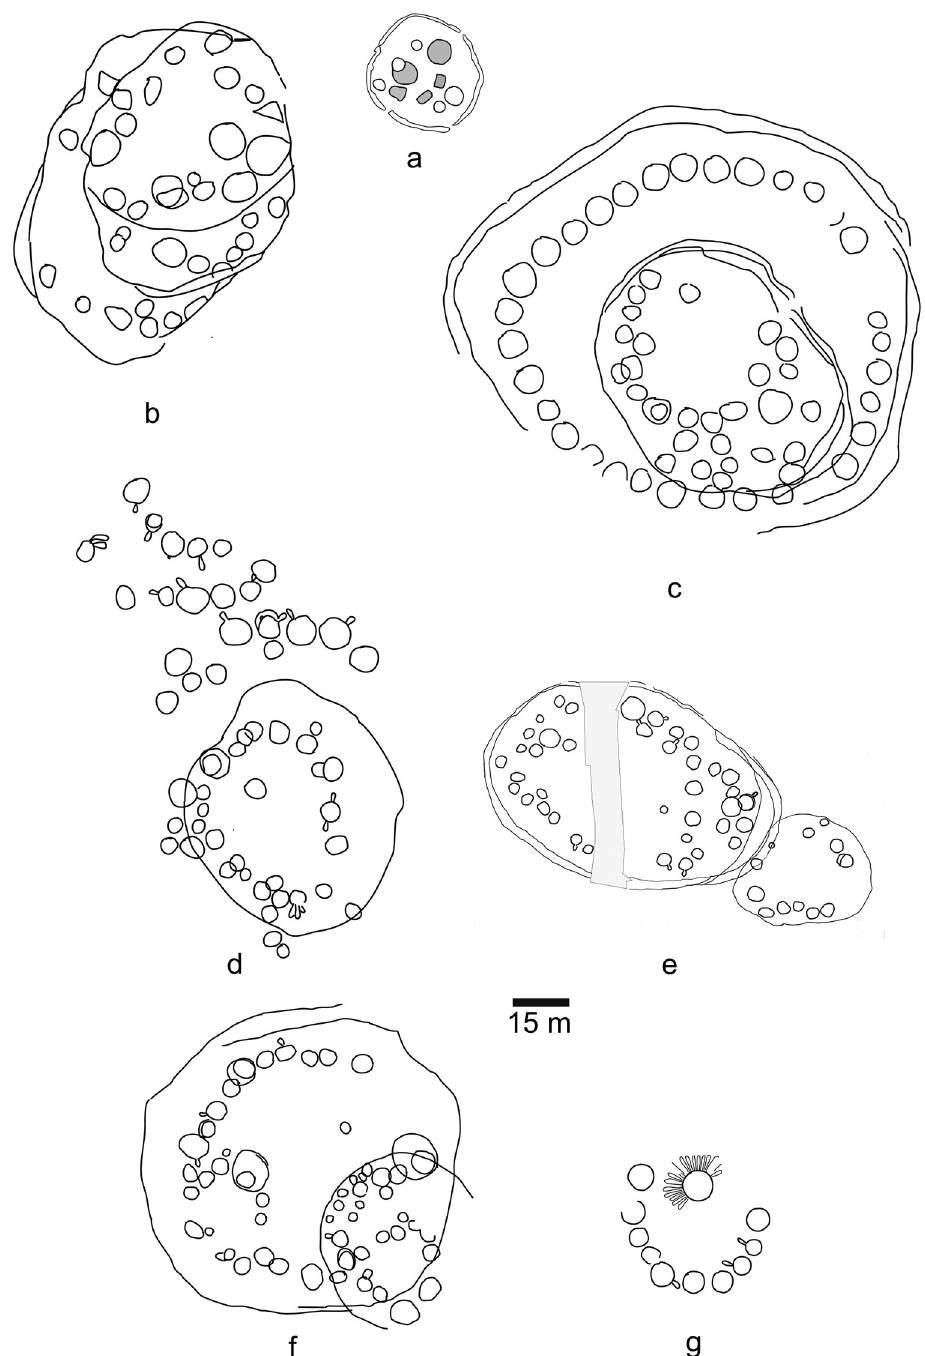
Fig 4. Site plans showing house and palisade outlines as inferred from postmold patterns for village sites discussed in the text: (a) Gnagey No. 3 (shaded structures represent the original site plan), (b) Fort Hill, (c) Peck No. 1, (e) Reckner, (f) Consol (shading represents roadway), (g) Peck No. 2, (f) Throckmorton. Overlapping house patterns represent rebuilding episodes rather than synchronically occupied structures.